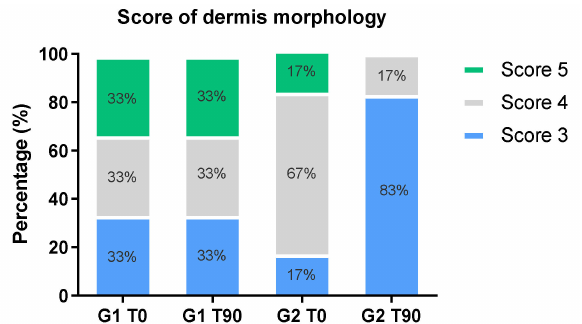
Figure 6. Score of dermis morphology (%) in the nasolabial region of the face of the participants before (baseline—T0) and after 90 days (T90) of supplementation with hydrolyzed fish cartilage or the placebo. The results are reported as relative frequency of scores. Triplicate images of each participant were analyzed using the Vivastack ®